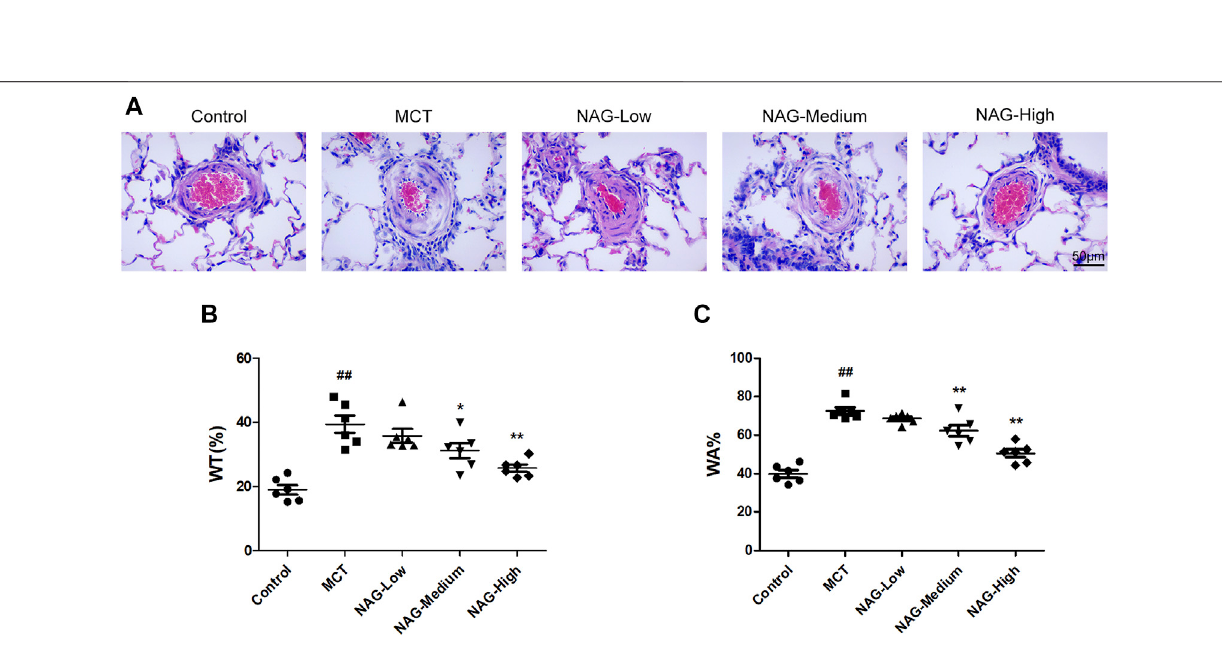
Frontiers in Pharmacology |